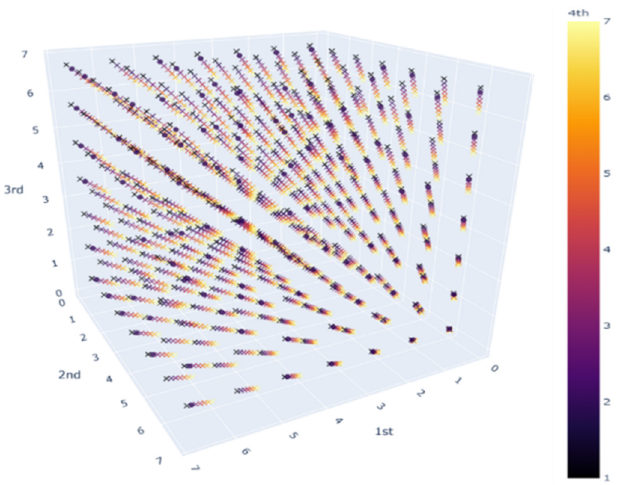
Figure 1. Distribution of Korean dataset.